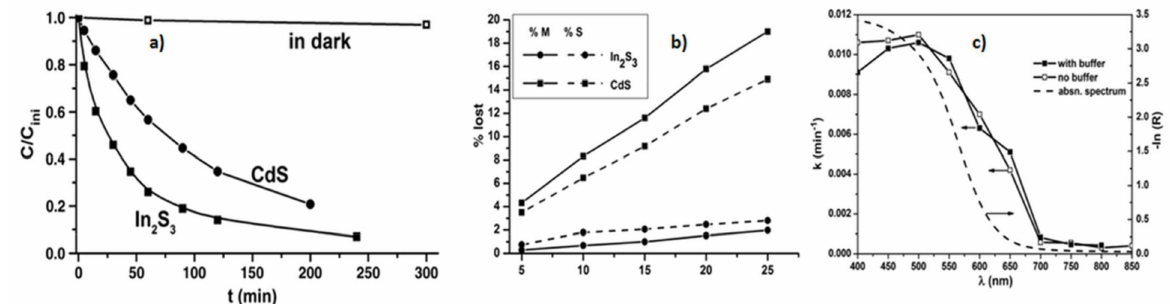
Figure 1. Photocatalytic use of In 2 S 3 for degrading aqueous HCOOH: ( a ) activity compared with CdS; ( b ) resistance to photocorrosion (from chemical analysis of S and metal ions gone into solution) compared with that of CdS; ( c ) spectral response of In 2 S 3 in this process, evaluated through its first order rate constant, compared with the diffuse reflectance spectrum of the material (Adapted from Ref.